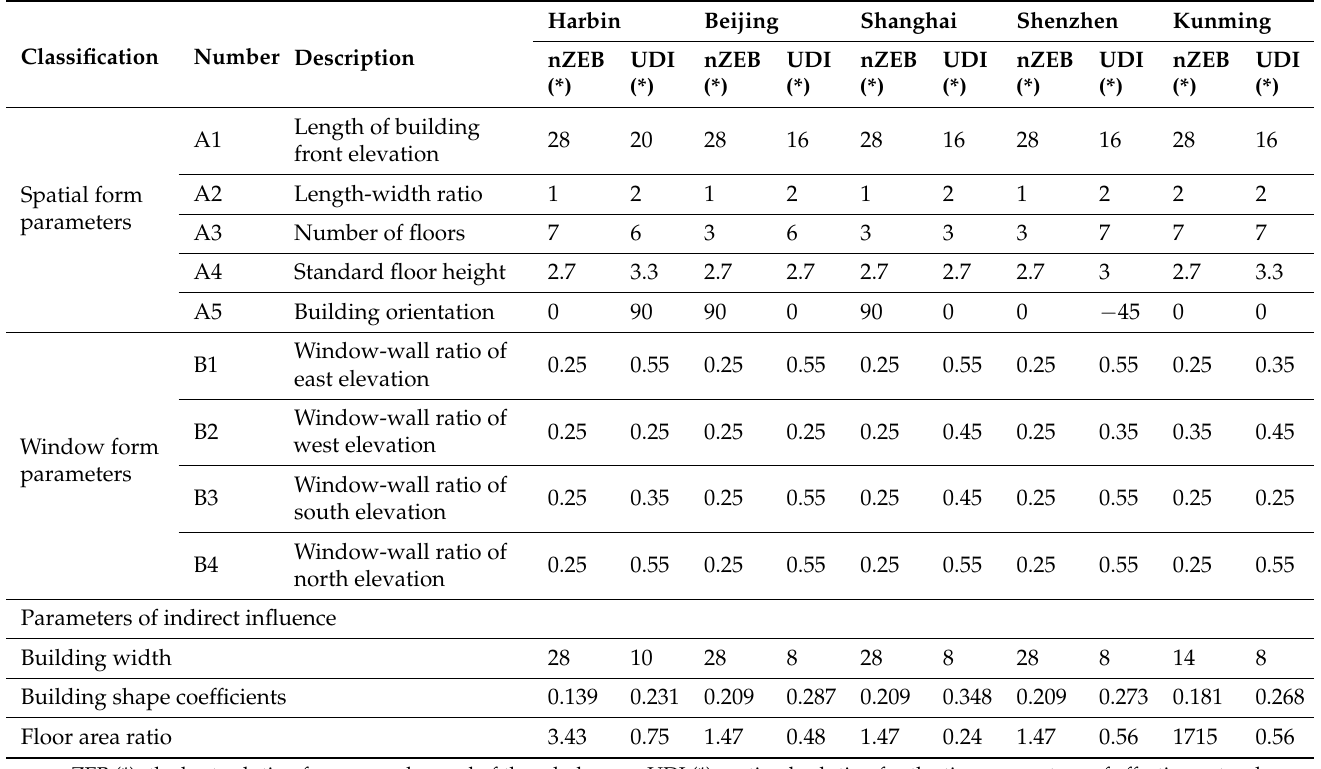
Table 17. Optimization design parameters of building forms in each typical